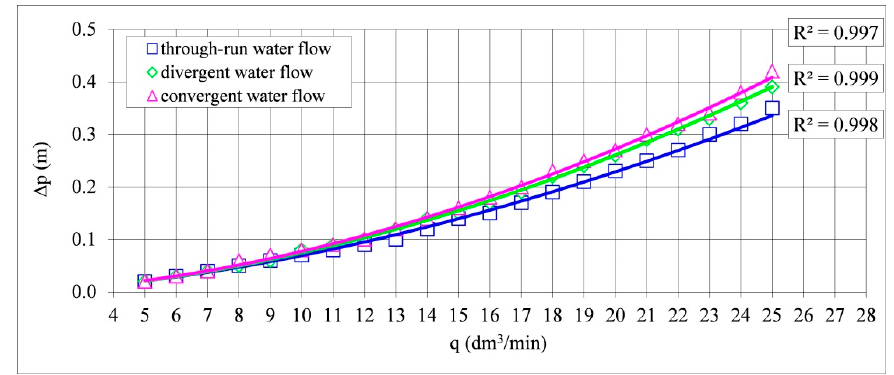
Figure 5. Dependence between the mean pressure di ff erence ∆ p in the screwed joints and polypropylene pipe sections and the water flow rate